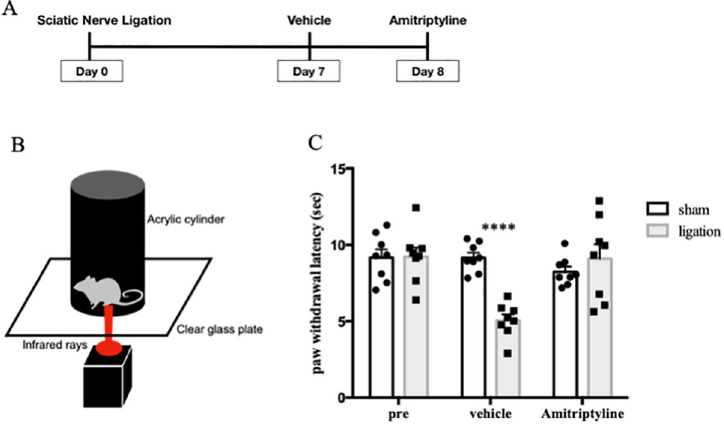
Fig 2. Amitriptyline improved thermal hyperalgesia in neuropathic pain model. Plantar tests were performed before nerve ligation surgery, test day 7 with vehicle, and test day 8 with amitriptyline administration (n = 8) (A). Schematic diagram of plantar test (B). Paw withdrawal latencies were plotted for every test (C). Data are expressed as means ± SEM. Data are analyzed using two-way ANOVA followed by Bonferroni’s post hoc test and considered statistically significant at ���� P < 0.0001 when comparing the sham and ligation groups.